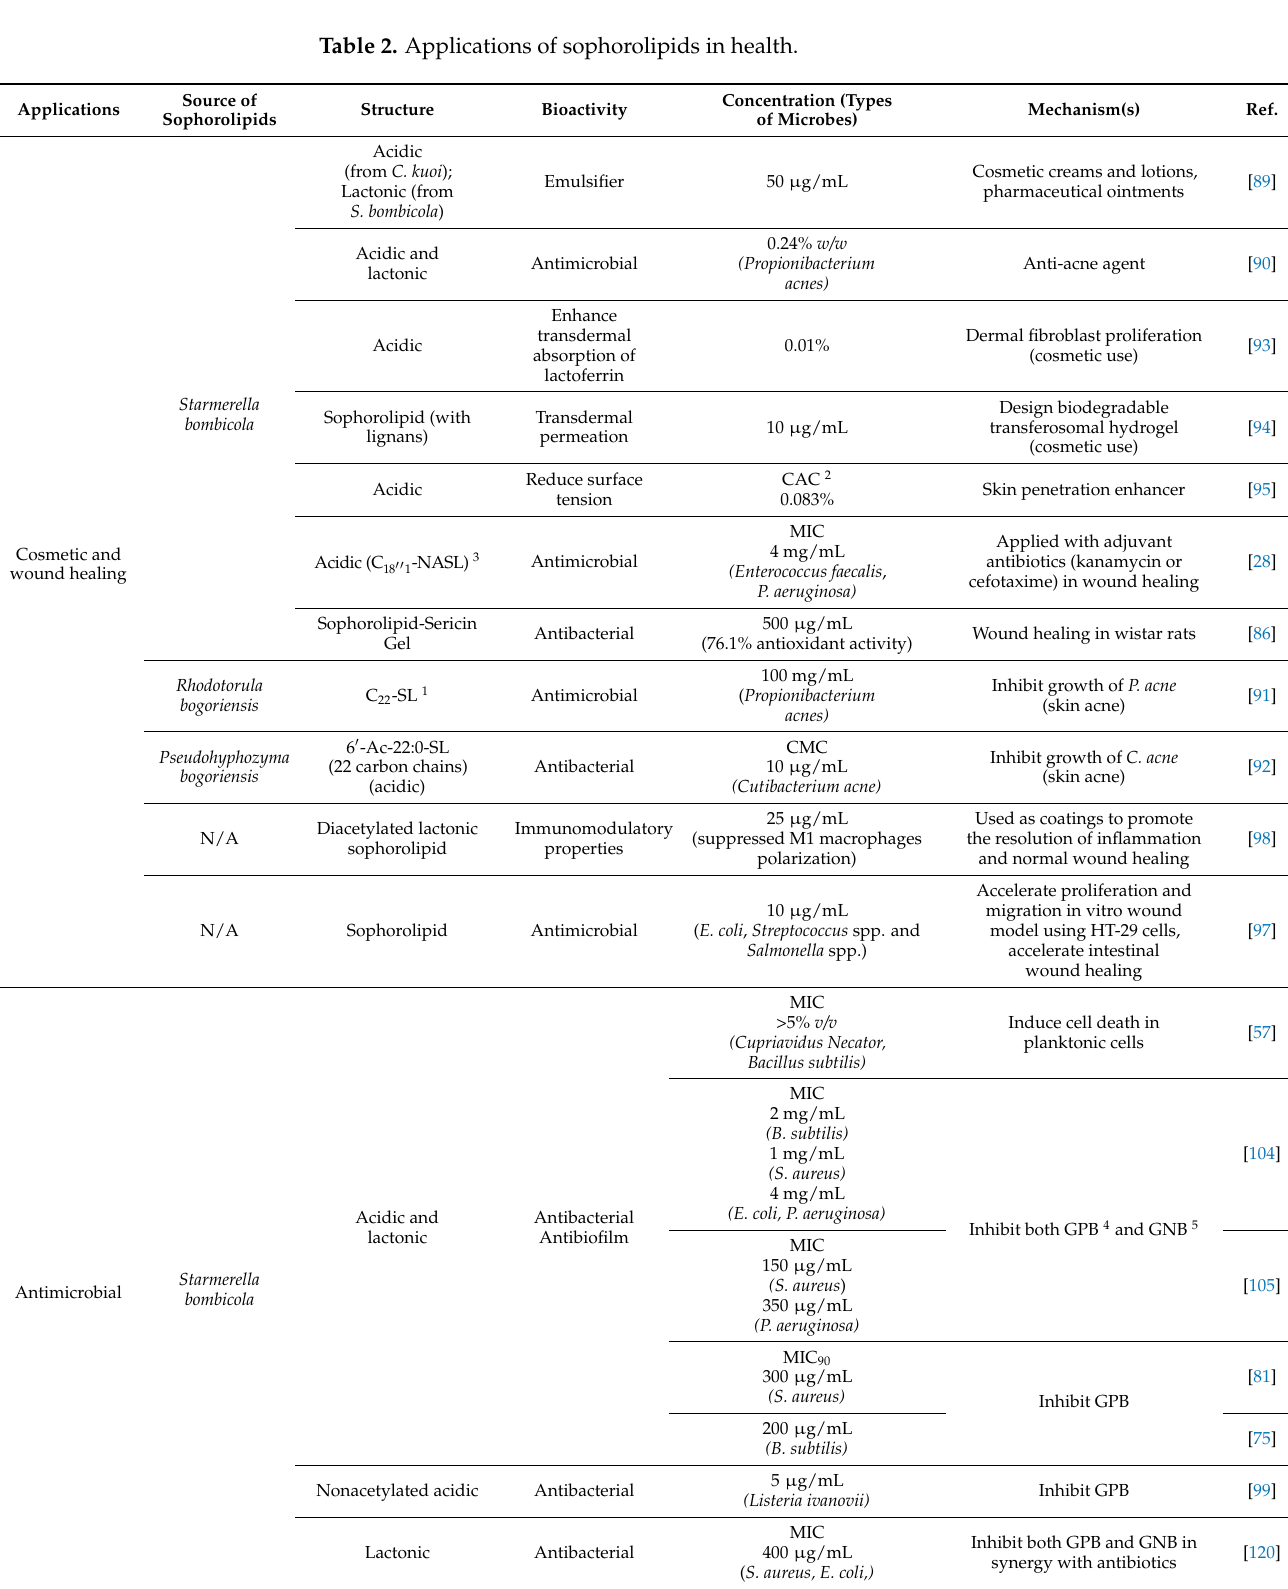
Table 2. Applications of sophorolipids in